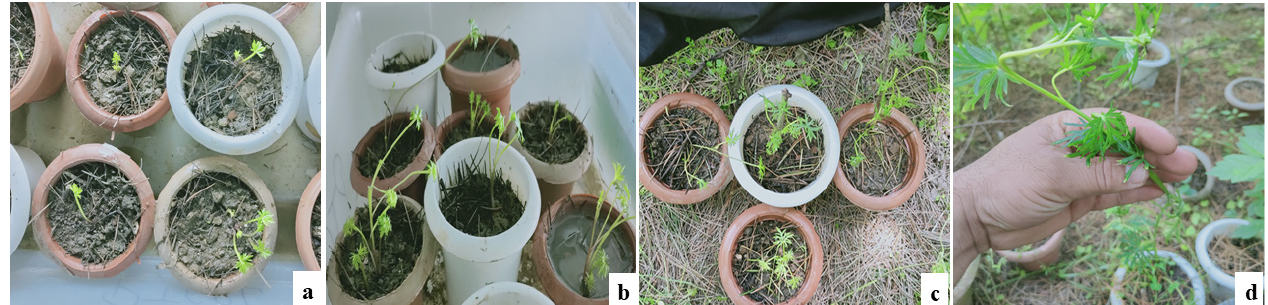
ANOVA) at p ≤ 0.05.